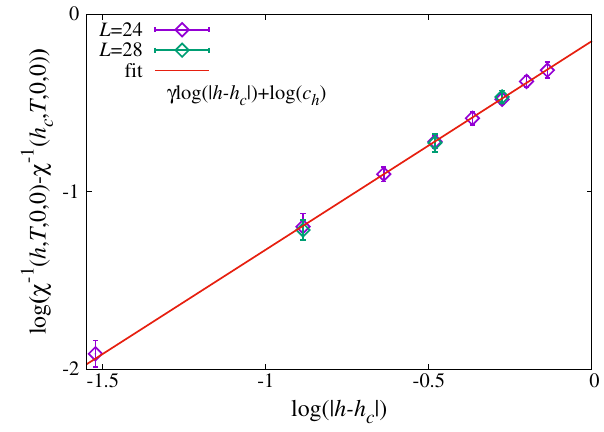
FIG. 7. Finite-temperature FM-to-PM phase transition at T ¼ 0 . 5 . Panel (a) shows the fermion spin susceptibility at q ¼ 0 and ω 0 , and panel (b) shows the data collapse n ¼ according to Eq. (C1). Note that h N is a free fitting parameter and the best data collapse gives h N ð T ¼ 0 . 5 Þ ≈ 3 . 06 .